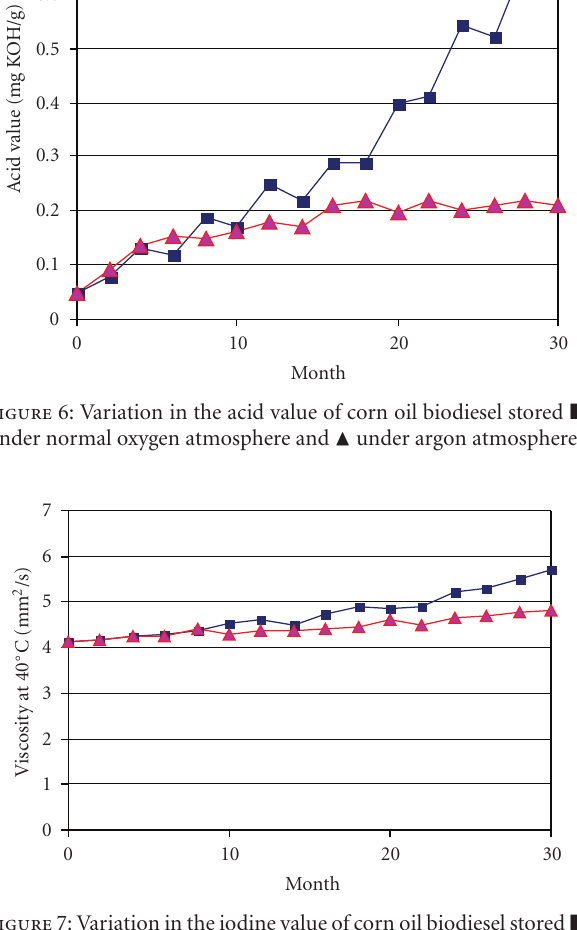
Figure 7: Variation in the iodine value of corn oil biodiesel stored (cid:2) under normal oxygen atmosphere and (cid:3) under argon atmosphere.